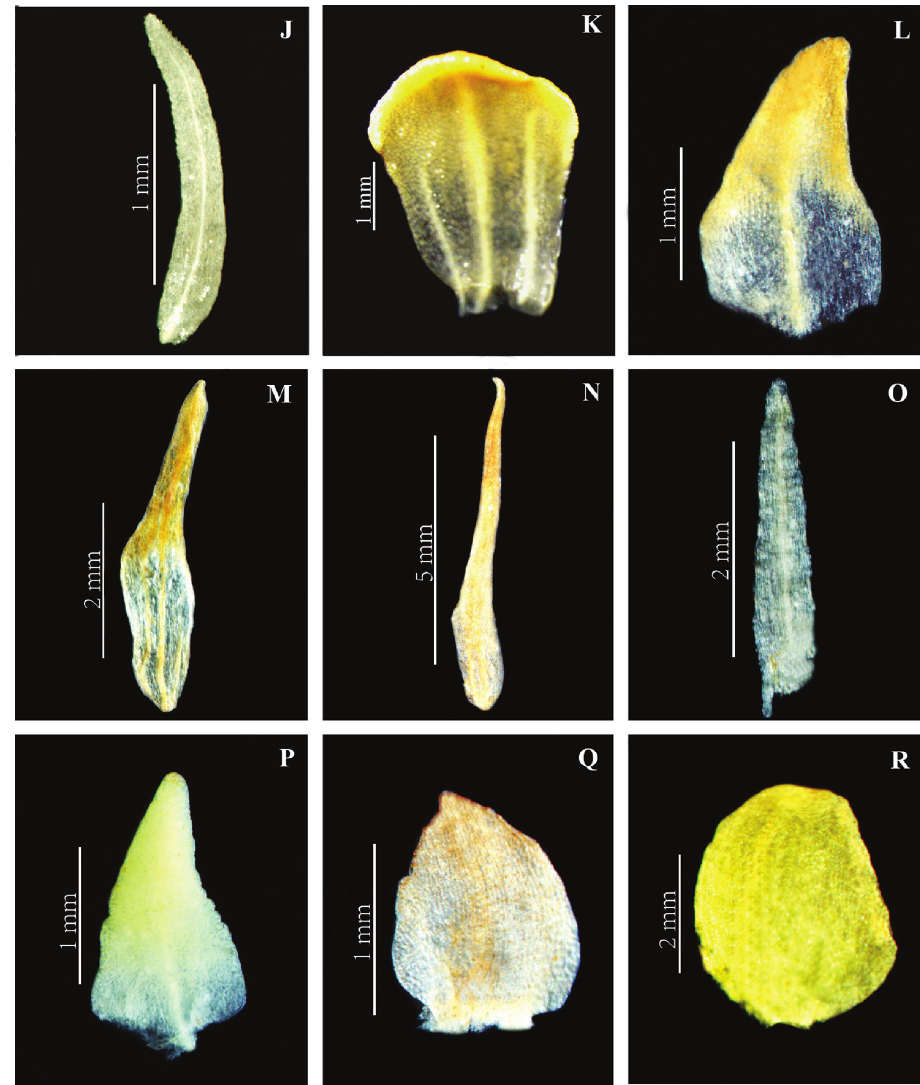
Figure 8. Continued. Petal of Herminium . J H. fallax K H. himalayanum L H. elisabethae M H. alaschani- cum N H. ophioglossoides O H. quinquelobum P H. macrophyllum Q H. ecalcaratum R H. biporosum.